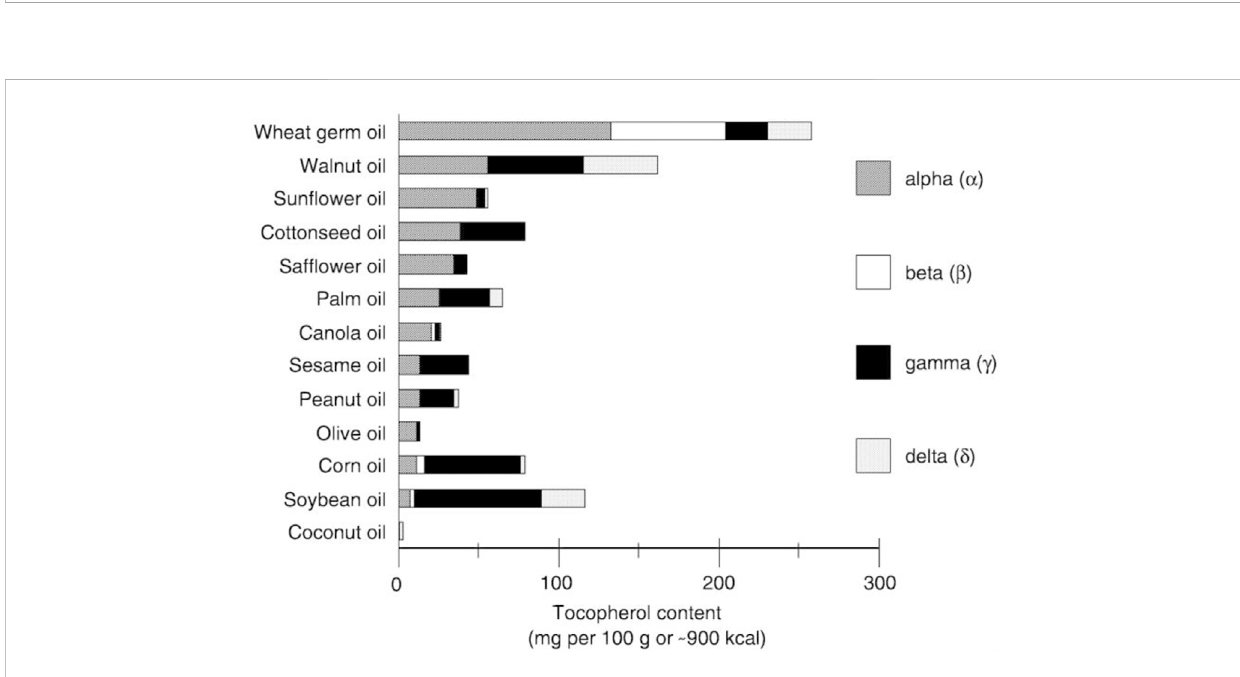
Content of the four homologues of vitamin E in oils. (From: NCBI,